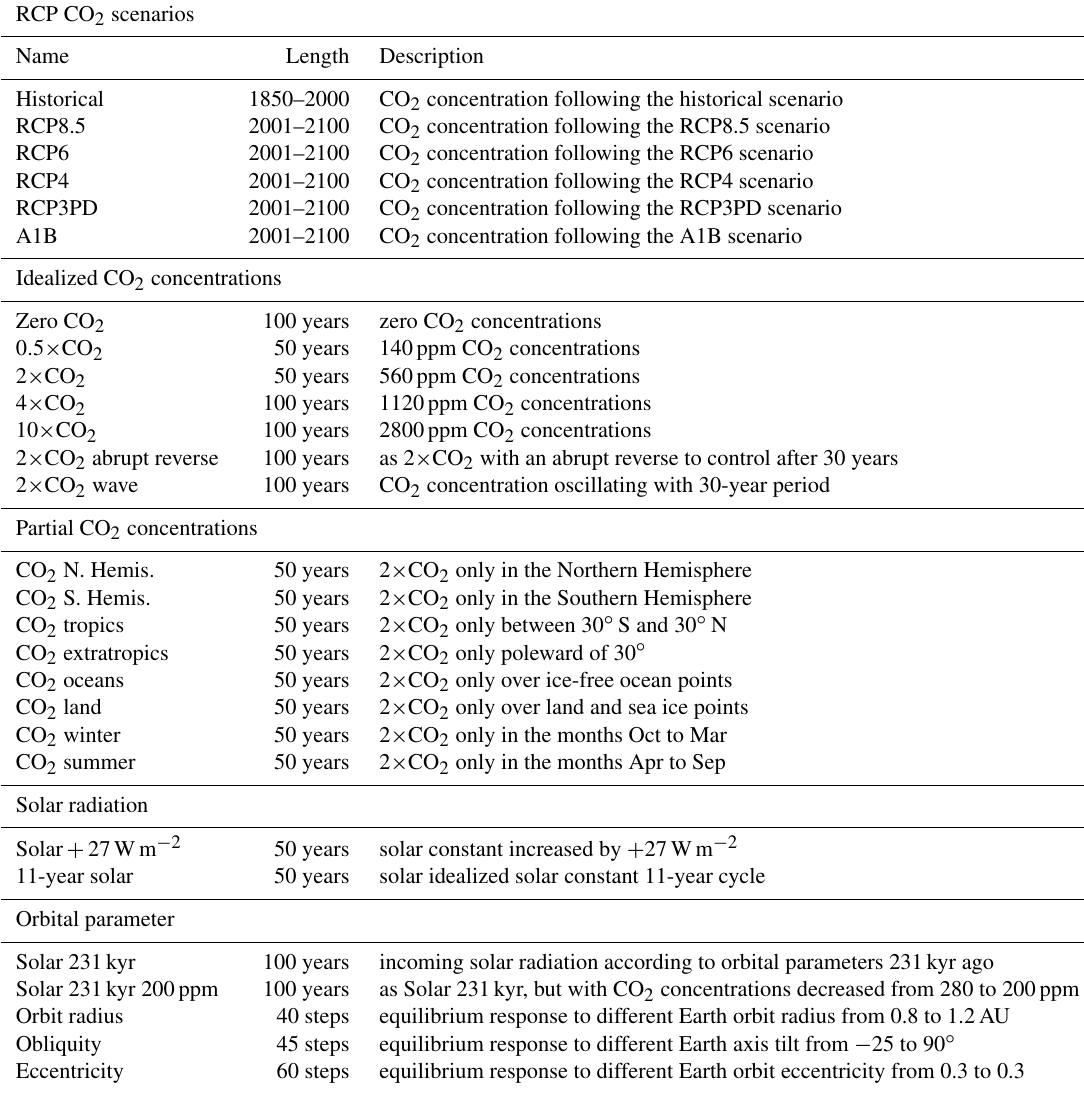
Table 3. List of scenario